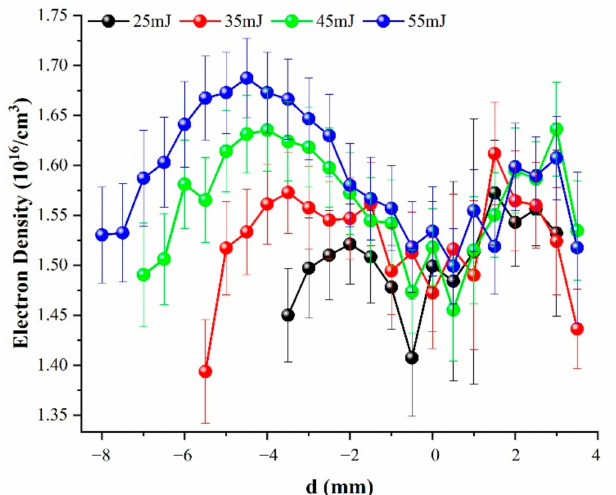
Figure 7. Effect of pulse energies and d on the electron density (the error bar is derived from the error of fitted ∆ λ